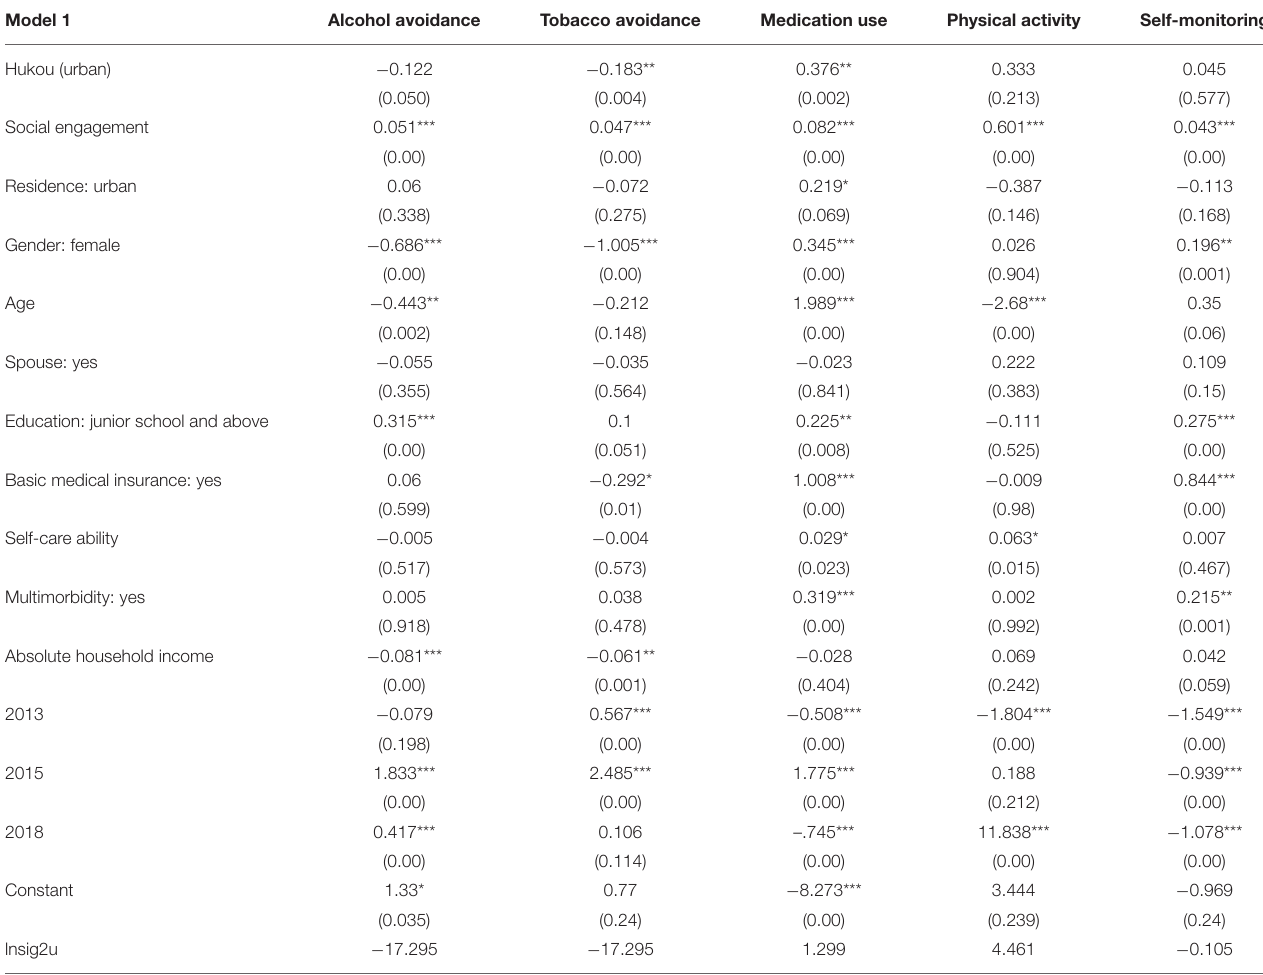
TABLE 3 | Random-effect panel logit regressions reporting urban-rural disparities of self-management behaviors. Model 1 Alcohol